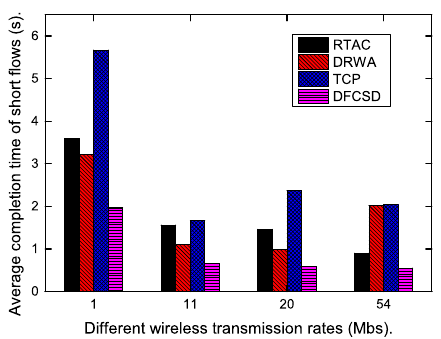
Figure 16. The FCT of the short flows when the wireless bandwidth varies from 1 Mbps to 54 Mbps when long flows exist.